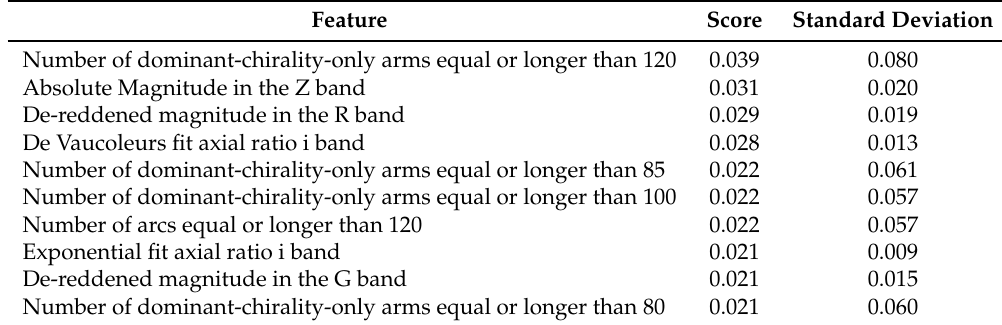
Table 6. Top 10 best features for spirality prediction in decreasing order of importance. The standard deviation is measured across the 150 decision